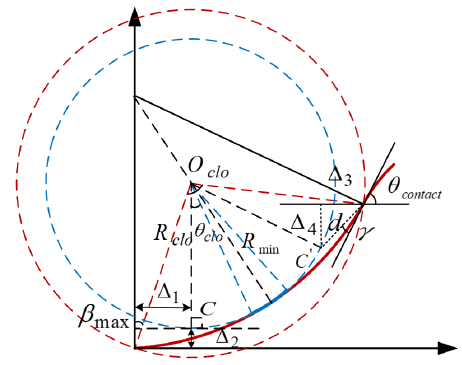
Figure 11. Continuous-curvature turns.